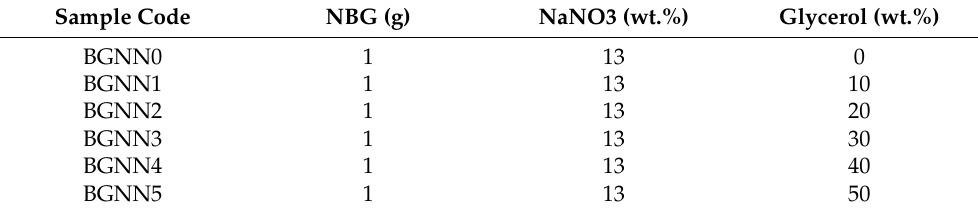
Table 1. Composition of unplasticisedandplasticisedNBG:NaNO 3 :glycerol films. Sample